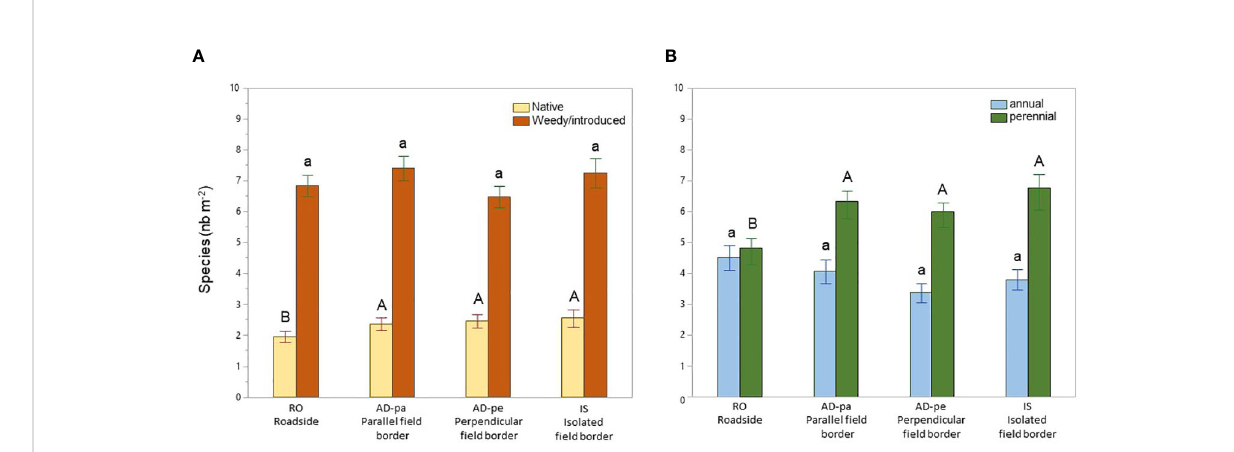
FIGURE 5 Species richness of native and weedy/introduced species (A) as well as annual and perennial species (B) along roadsides and fi eld borders. Different letters indicate signi fi cant differences at alpha=0.05 within plant type, Error bars indicate ±STE.